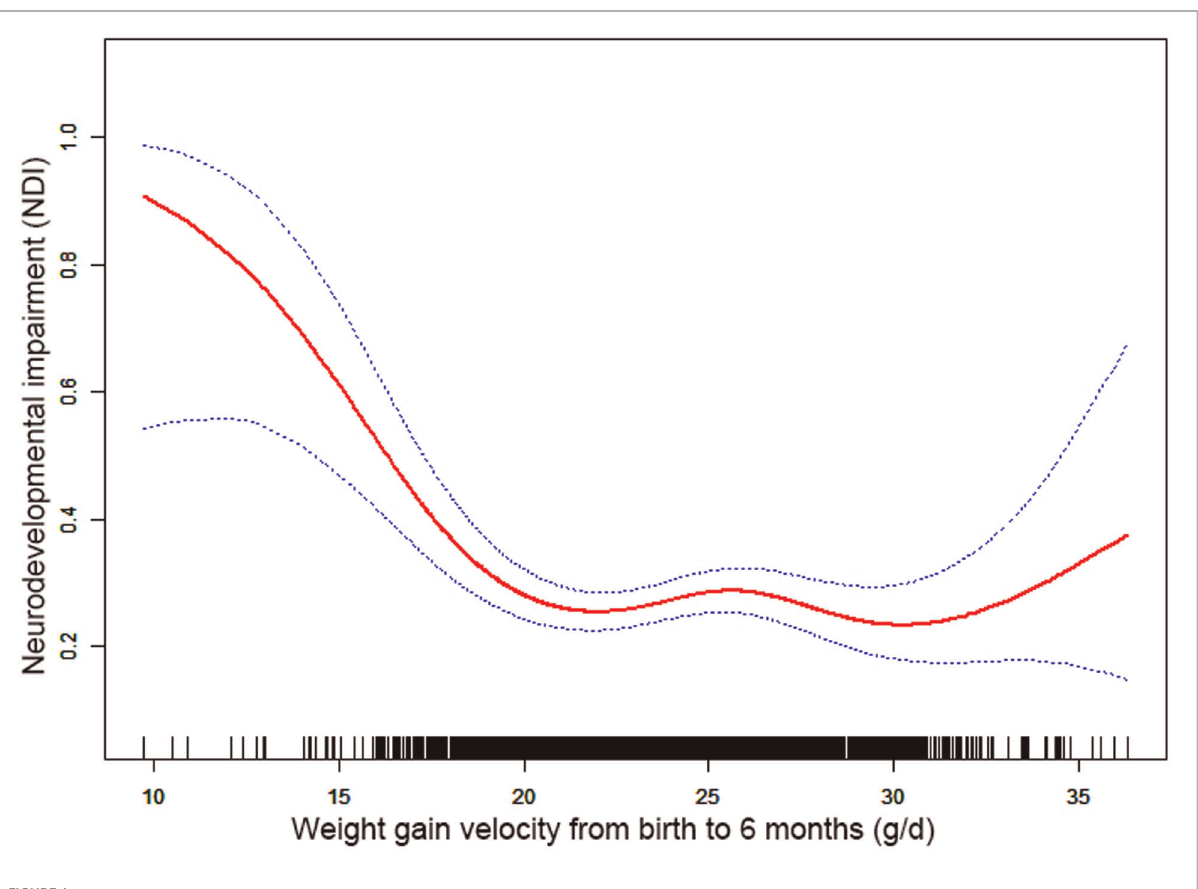
FIGURE 1 Nonlinearity of weight gain velocity from birth to 6 months CA on neurodevelopmental